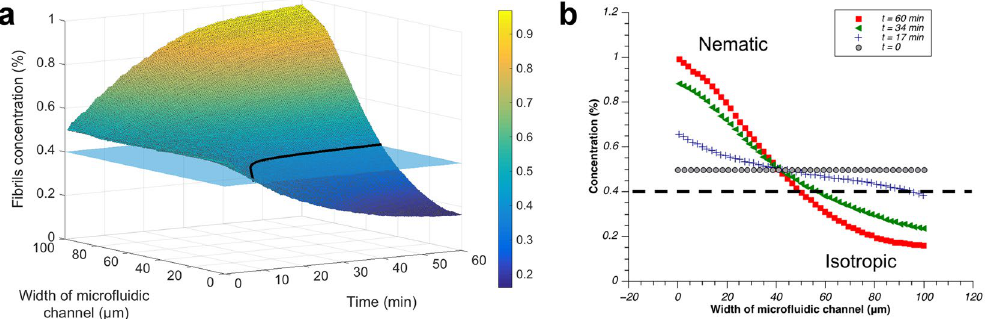
Figure 3. Temporal evolution of the concentration profile of a 0.5% w/w sample, at an average temperature of 17.8 °C in the presence of a temperature gradient of 20 °C/mm. ( a ) The colours represent local fibrils concentration, the plane shows the concentration at which the nominal transition between I and N under quiescent conditions is expected, and the black continuous line shows the corresponding position in the channel versus time, separating I and N phases under quiescent conditions. ( b ) Two-dimensional concentration profiles at different times. The black dashed line corresponds to the critical fibril concentration for the nominal I - N phase transition under quiescent